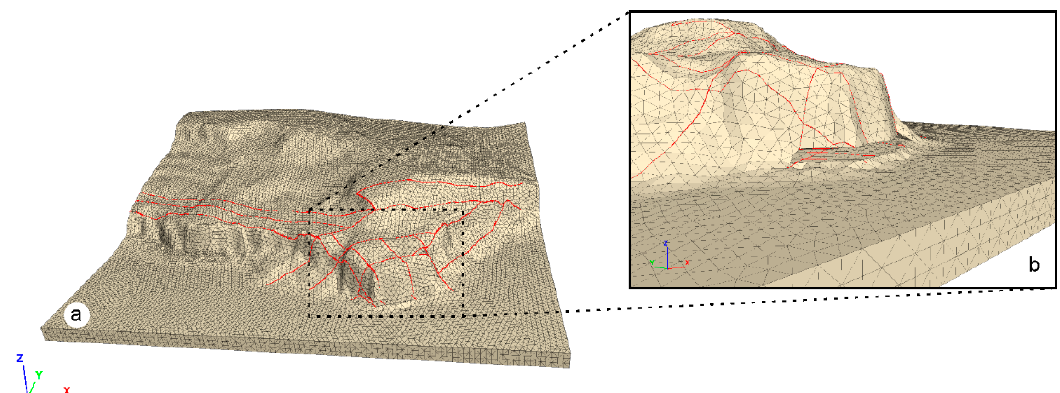
Figure 5. ( a ) Discretization mesh used for the numerical modelling; and ( b ) detail of the grid next to a notch. The red lines indicate the main joints.